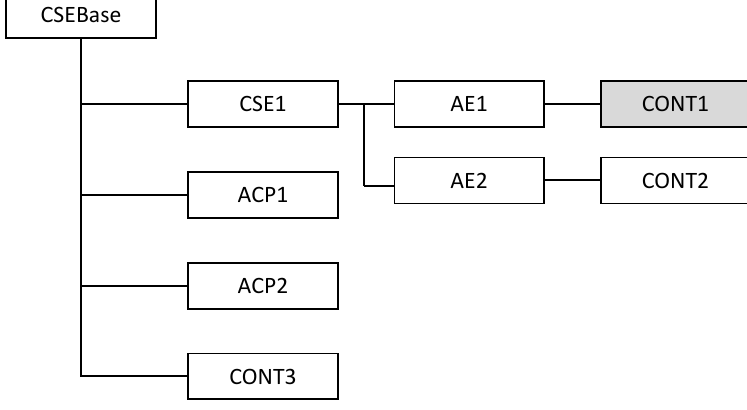
Figure 3. Resource-oriented architecture (ROA)-based oneM2M resource structure.